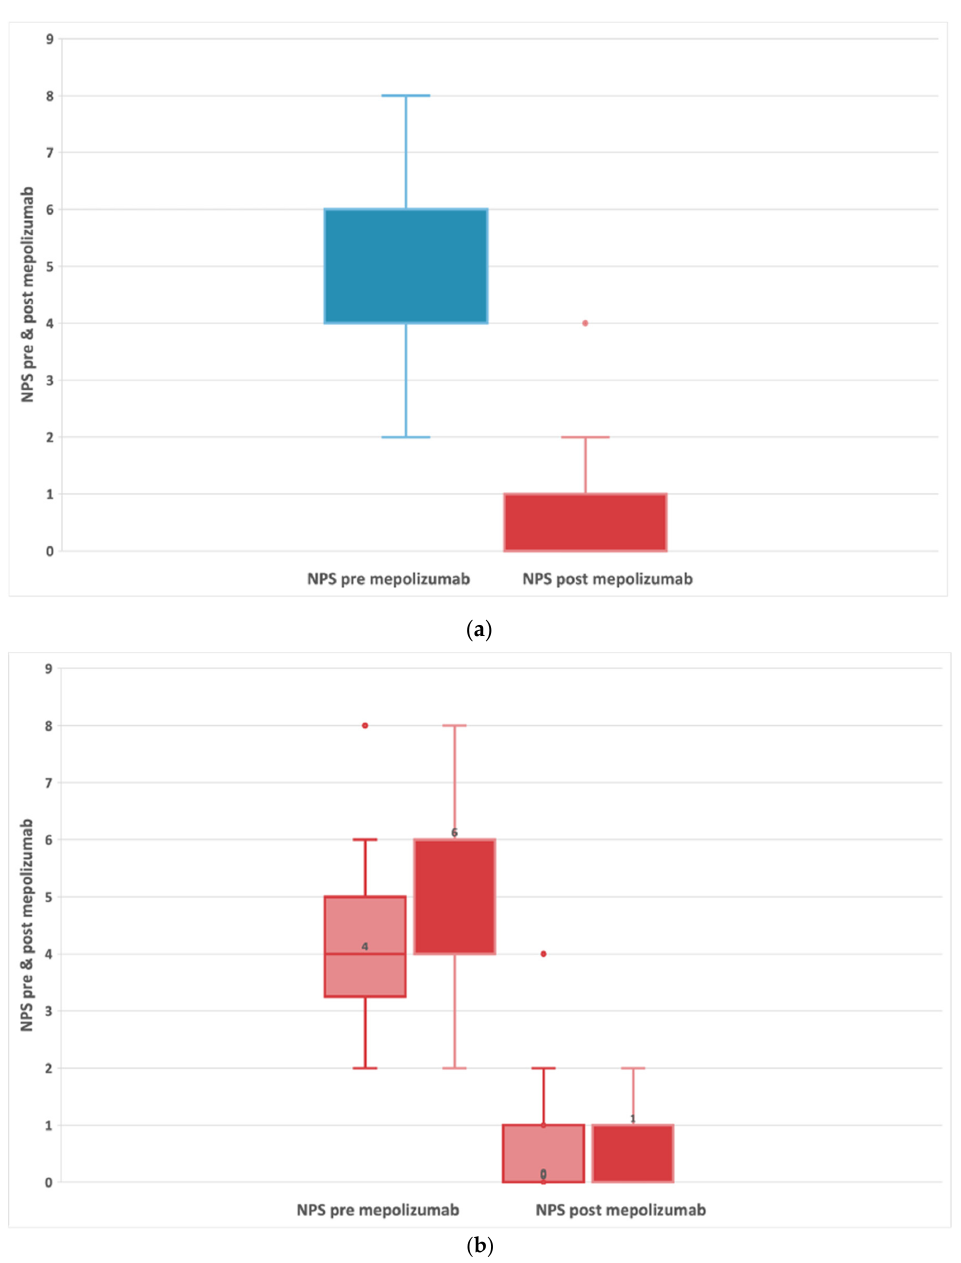
Figure 3. ( a ) Evolution of NPS in patients with refractory chronic rhinosinusitis and nasal polyps, pre-treatment and after 24-week treatment with 100 mg of mepolizumab every 4 weeks. ( b ) Evolution of NPS in patients with refractory chronic rhinosinusitis and nasal polyps, comparing subjects with and without AERD pre-treatment and after 24-week treatment with 100 mg of mepolizumab every 4 weeks.